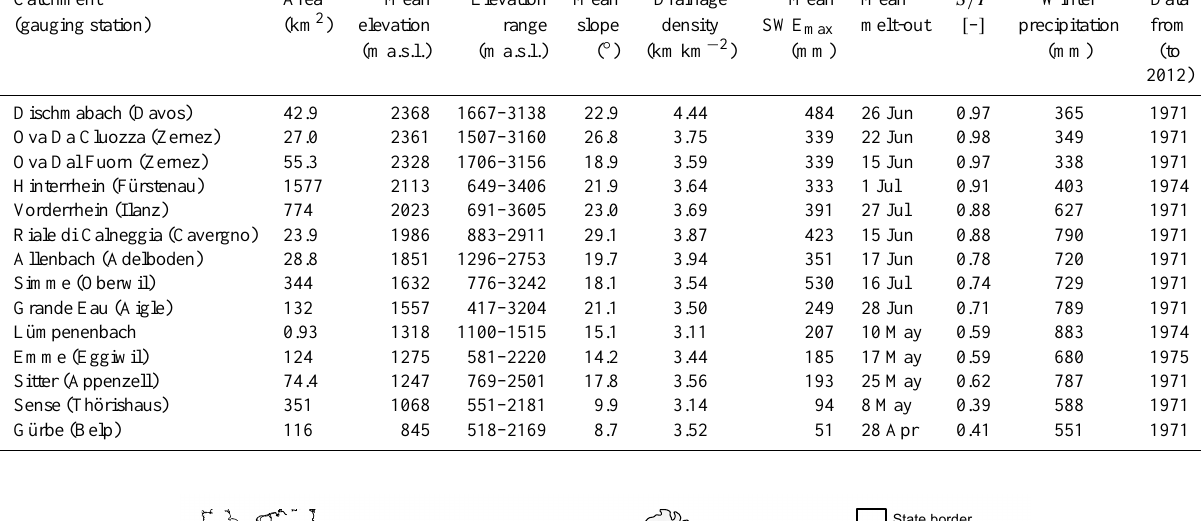
Table 1. Study catchments and selected characteristics ( S/P refers to the ratio of snowfall to total precipitation). Catchment (gauging station)